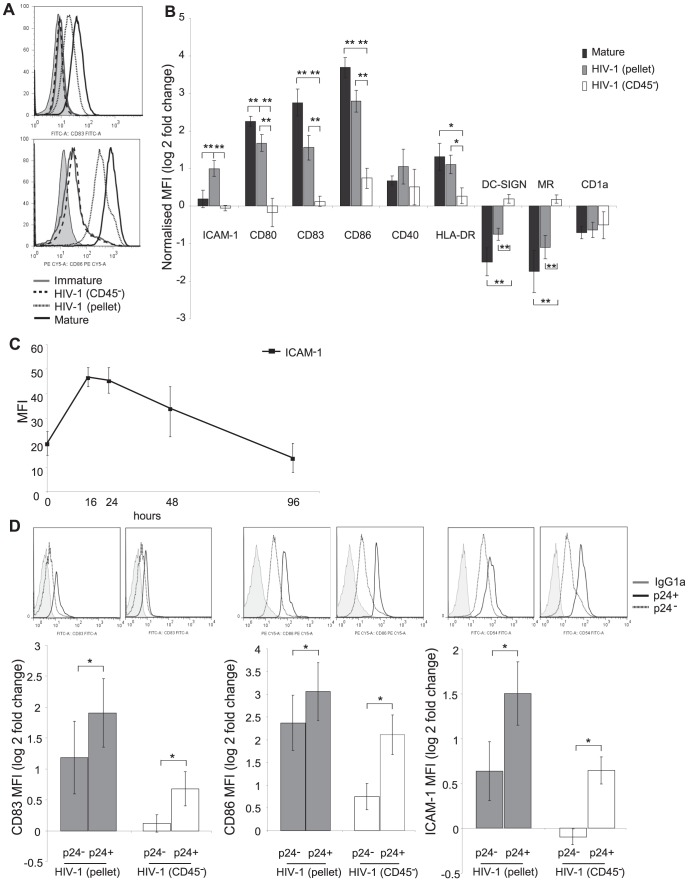
HIV-1BaL(CD45−) induces less maturation than HIV-1BaL(pellet).MDDCs were exposed to high titre HIV-1BaL(pellet), HIV-1BaL(CD45−) at a MOI of 3 or a potent maturation cocktail for 48 hours and expression of maturation determined by flow cytometry. A) Representative histograms for CD83 and CD86 shown (isotype grey tint, immature solid grey line, HIV-1BaL(CD45−) dashed line, HIV-1BaL(pellet) dotted line and mature solid black line). B) The levels of surface maturation marker expression with flow cytometry MFI results expressed as a ratio of normalised to untreated (mock/immature) controls as log (2) fold change (mean +/− SEM, n = 12, *p<0.05 **p<0.01). C) Kinetics over time of ICAM-1 expression determined by flow cytometry MFI for HIV-1BaL(pellet) treated MDDCs (mean +/− SEM, n = 3). D) Productively infected MDDCs are more mature than uninfected MDDCs for both virus stocks. Infected cells were identified by p24 antigen staining and the expression of CD83, CD86 and ICAM-1 was compared to that for the HIV-1 exposed uninfected cells. Representative histograms for the markers of p24+ (dashed line) and p24− (dotted line) compared to isotype control (grey tint) for HIV-1BaL(pellet) and HIV-1BaL (CD45−). Bar graphs delineating the expression of normalised maturation and co-stimulatory marker expressed as log (2) fold change to mock treated cells (mean +/− SEM, n = 5, *p<0.05).